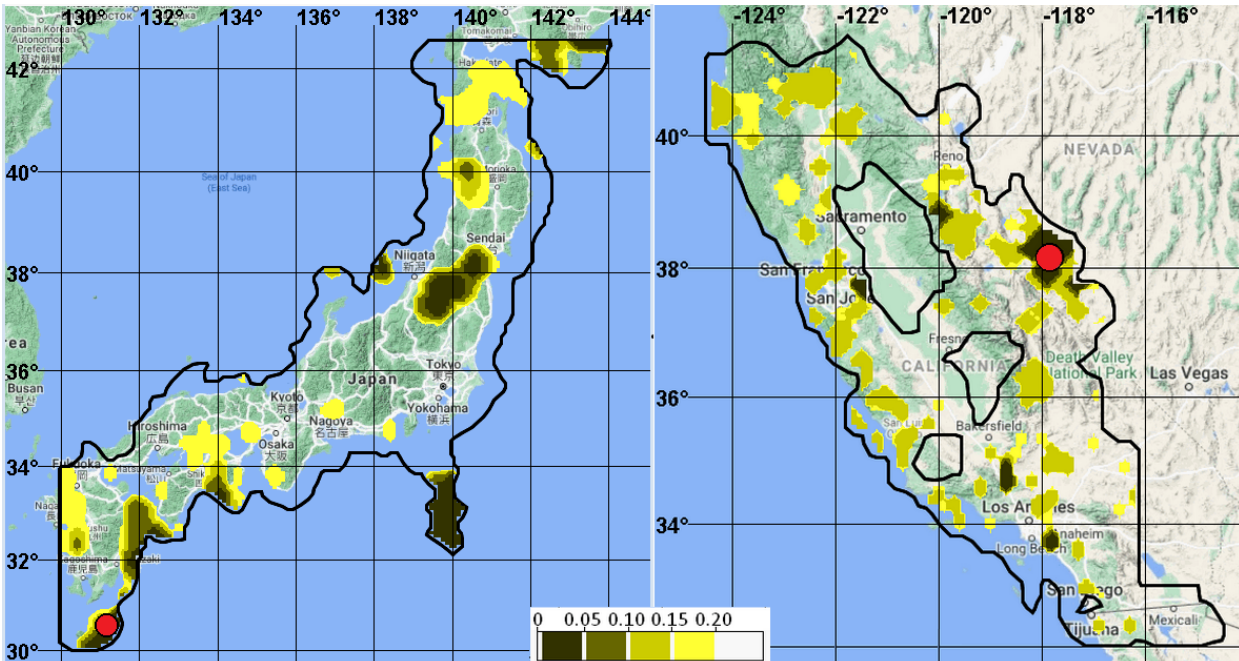
Figure 17. Alarm area zones of prognosis for Japan and California. ( Left ) Japan alarm area zone on 14 December 2018 with the epicenter of target earthquake with magnitude m = 6.3 on 8 January 2019; ( Right ) California alarm area zone on 17 April 2020 with the epicenter of target earthquake with magnitude m = 6.5 on 15 May 2020. The epicenters of the target earthquake are highlighted in red. Alarm volume values are shown on palettes in the picture. Field values with V > 0.2 are not